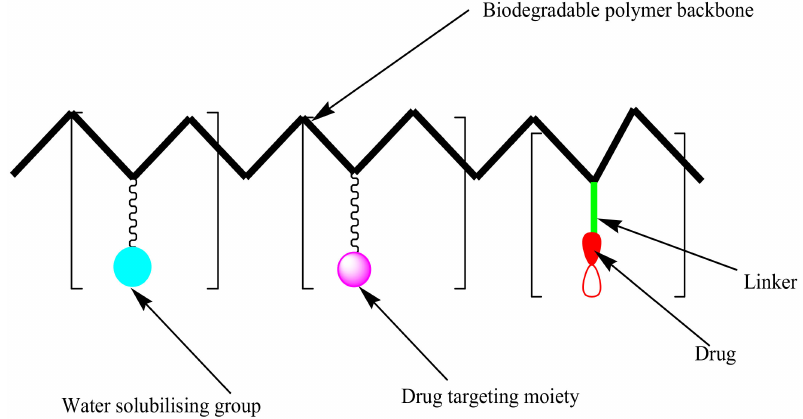
Figure 7. Schematic diagram of polymer-drug